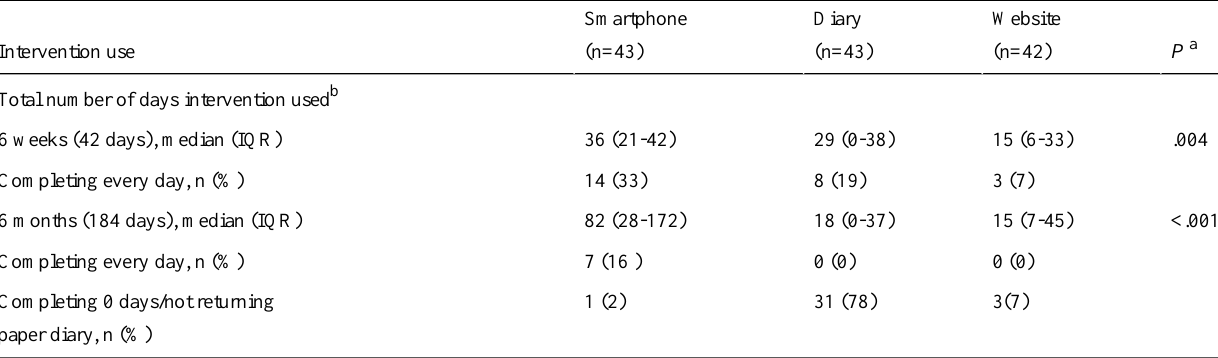
Table 4. Total number of days that the interventions were used